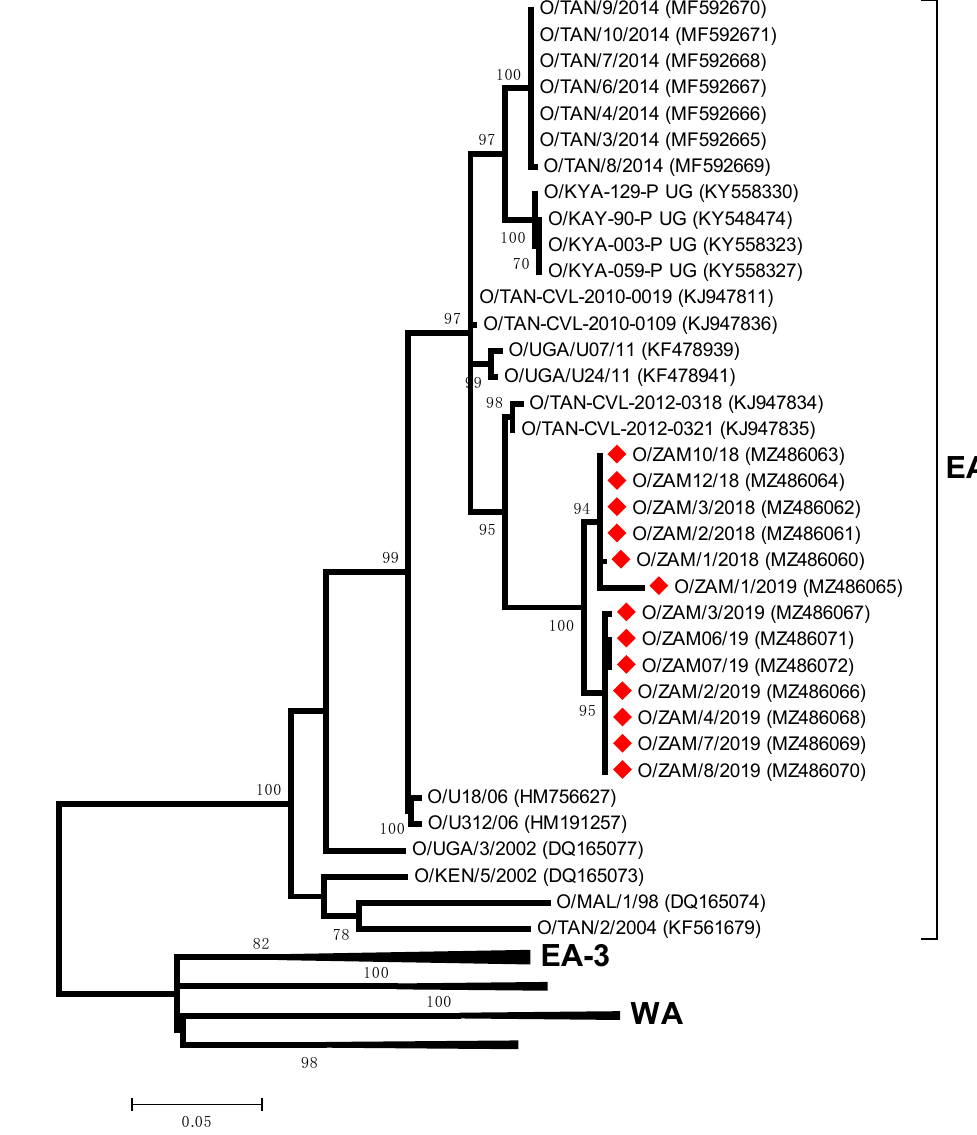
Figure 4. Midpoint-rooted maximum likelihood tree showing the relationships between the VP1 sequences of the 2018 foot-and-mouth disease virus O serotypes from Zambia (indicated with diamonds) and other contemporary and reference viruses.